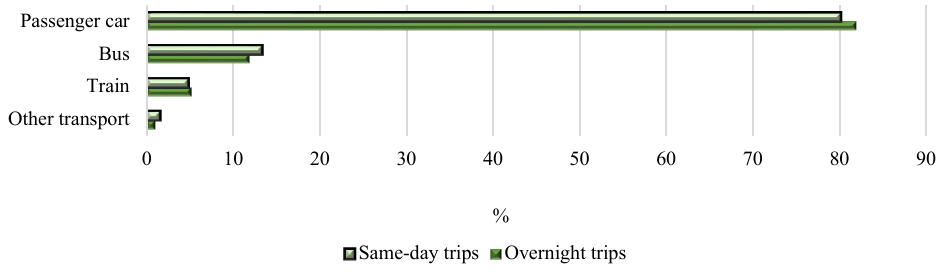
Fig. 2. Mode of transport used during overnight and same-day trips around Latvia 2018, % [8],